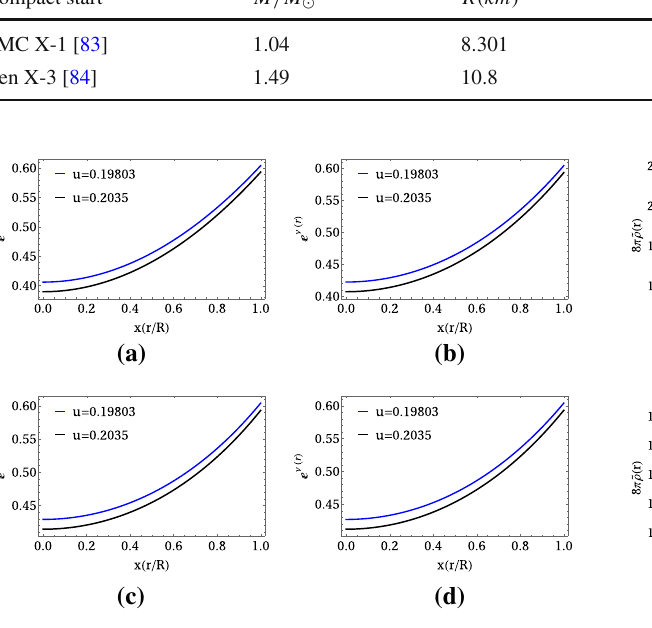
Fig. 1 e ν for Model 1 ( a ), Model 2 ( b ), Model 3 ( c ) and Model 4 ( d )